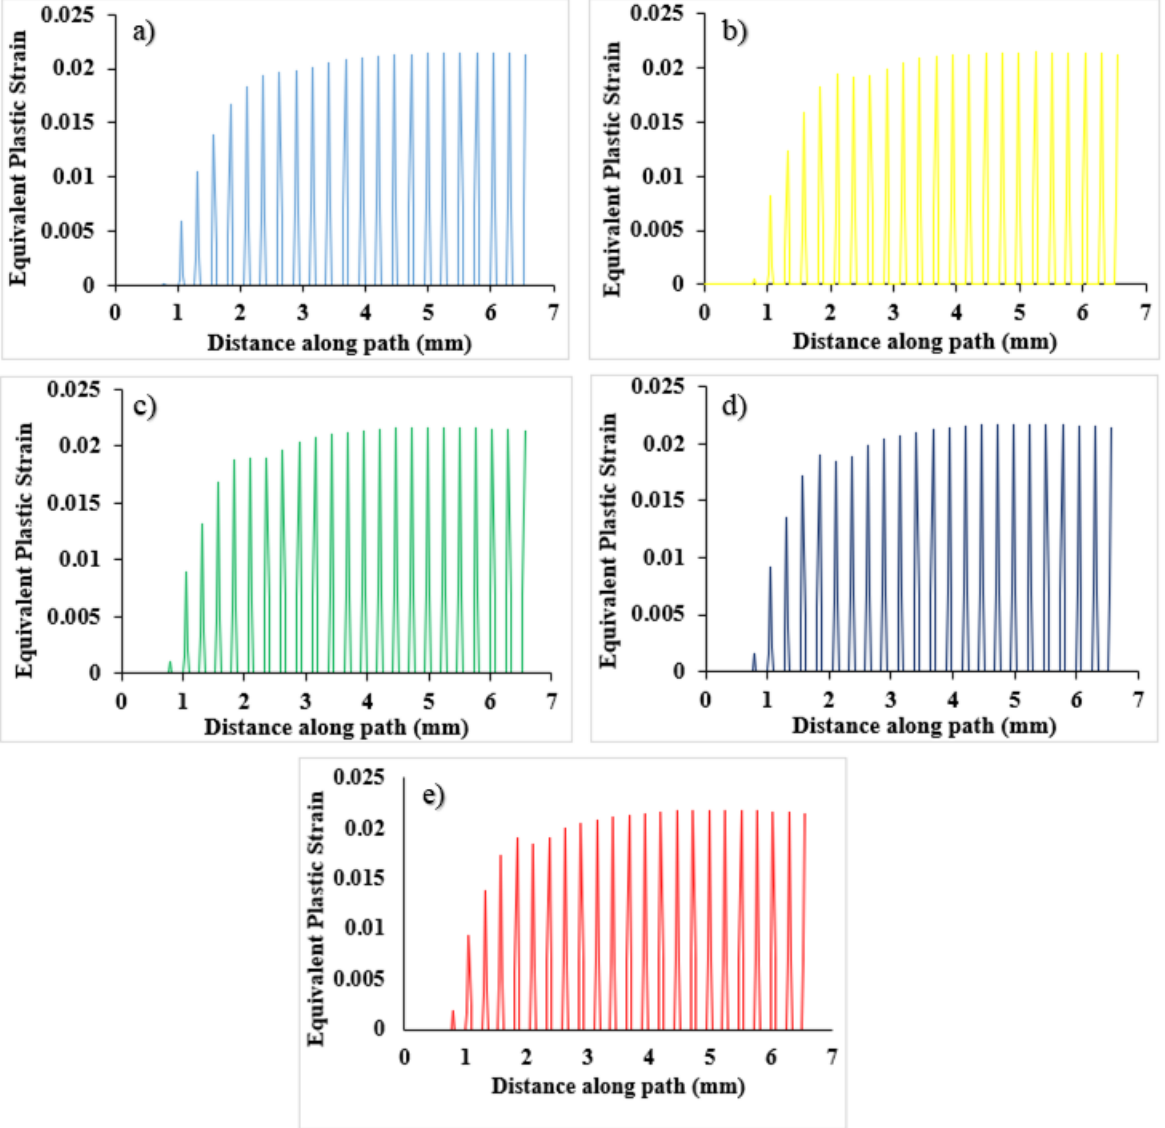
Figure 17. Equivalent plastic strain diagram in Path 2 in ( a ) Cycle 1, ( b ) Cycle 2, ( c ) Cycle 3, ( d ) Cycle 4, and ( e ) Cycle 5.